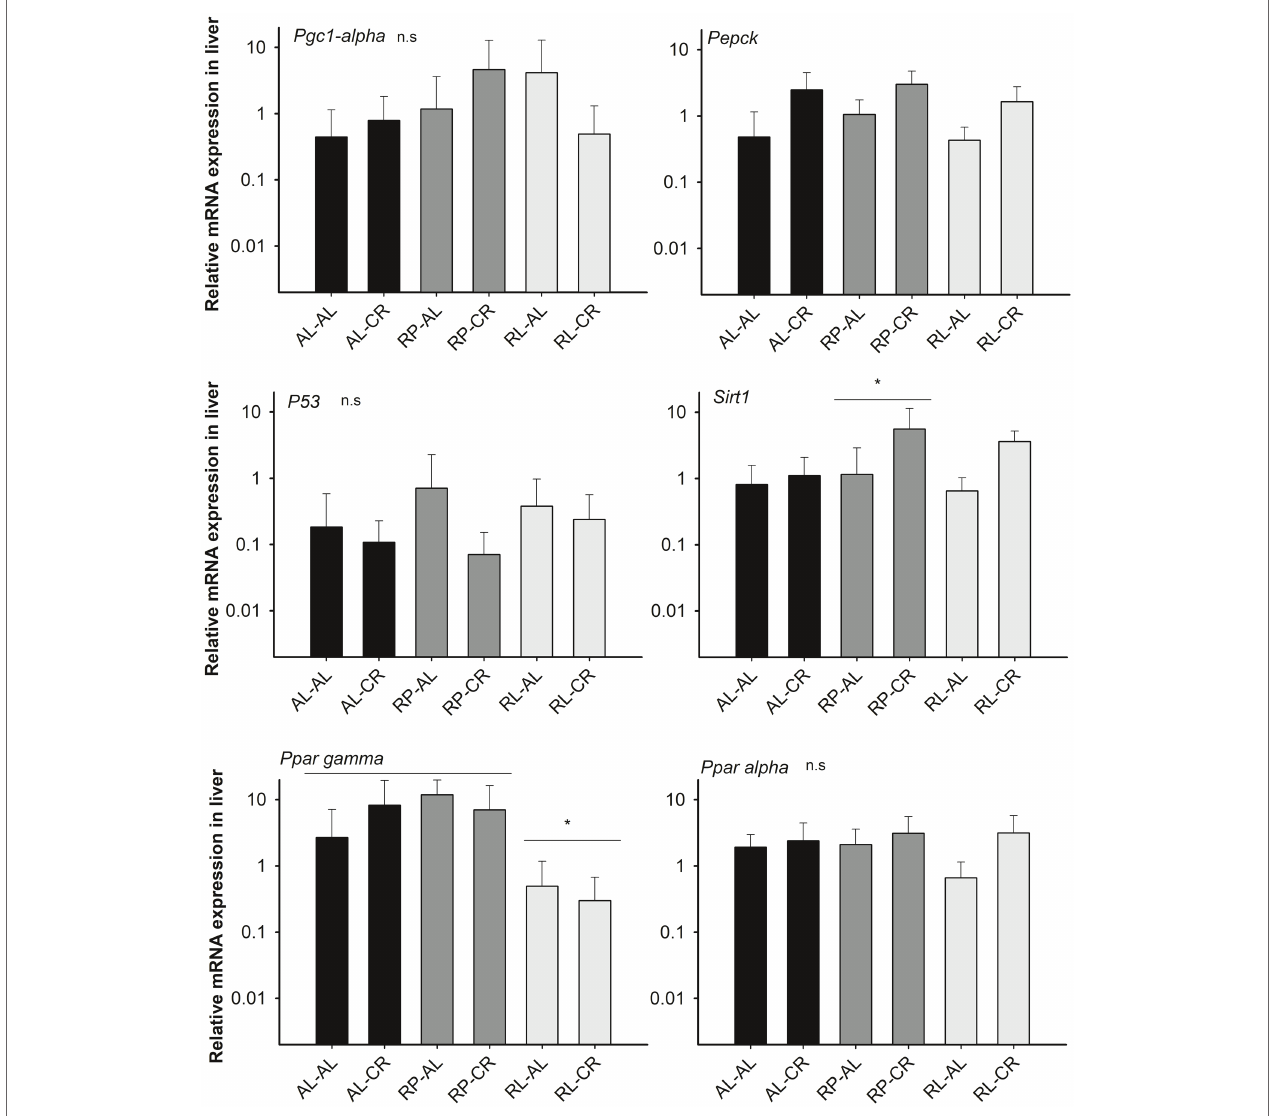
FIGURE 3 | Relative expression of Sirt1 (respect to B2m )-related genes in the liver of mice under treatments of perinatal and adult food availability as indicated. See statistical results in main text for all graphs. One asterisk: p <